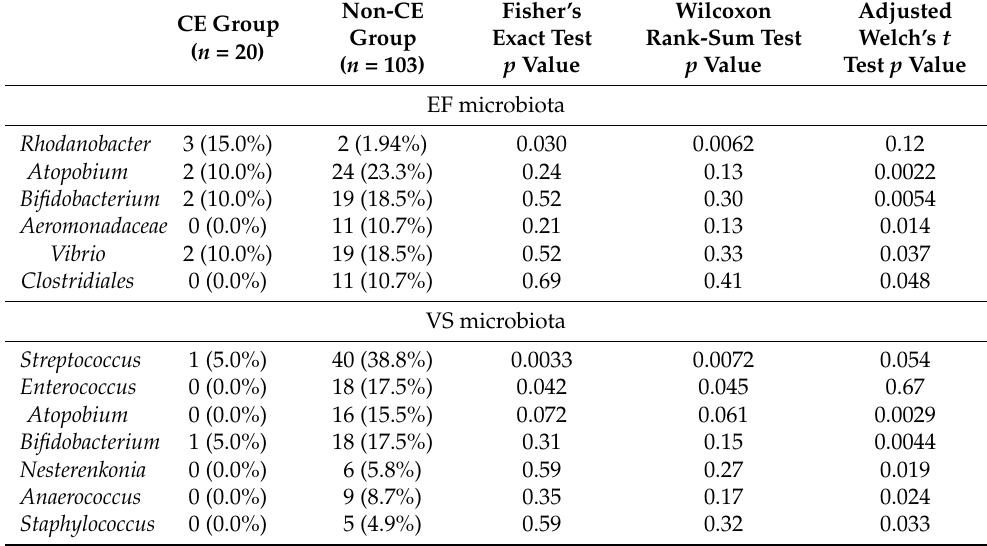
Table 3. List of bacterial genera of which detection rate and/or bacterial abundance in EF and VS microbiota significantly differed between the CE and non-CE